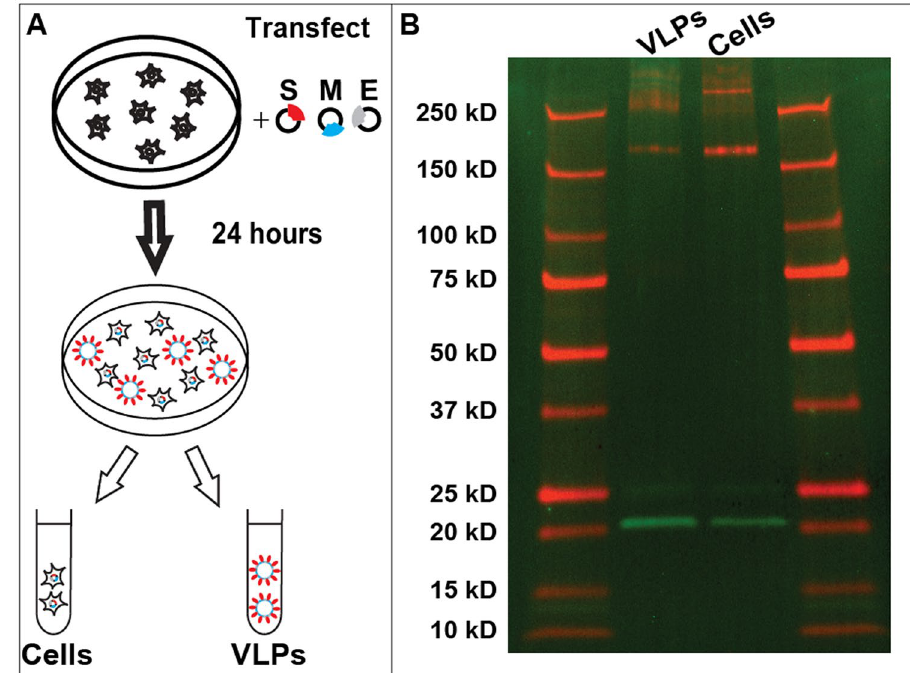
Figure 1. VLP expression and characterization using western blots. ( A ) Schematic representation of transfection and VLP harvest. ( B ) Western blot analysis of cells as well as VLPs separated as explained in methods. The gel was performed simultaneously, scanned at 700 nm and 800 nm, then superimposed using ImageJ (NIH) color merge for greater clarity, followed by cropping and minimal contrast enhancement. S protein (red) and M protein (green) are seen in two middle lanes. S protein tends to aggregate at very high concentrations (Fig. S2) resulting in smeared signal above 250 kD. S protein cleavage product is seen at 75 kD however the band is better visible when imaging channels are shown separately (Fig. S6). Protein size standards are described in “Methods” and are seen in leftmost and rightmost lanes. All size standard bands are also annotated on the